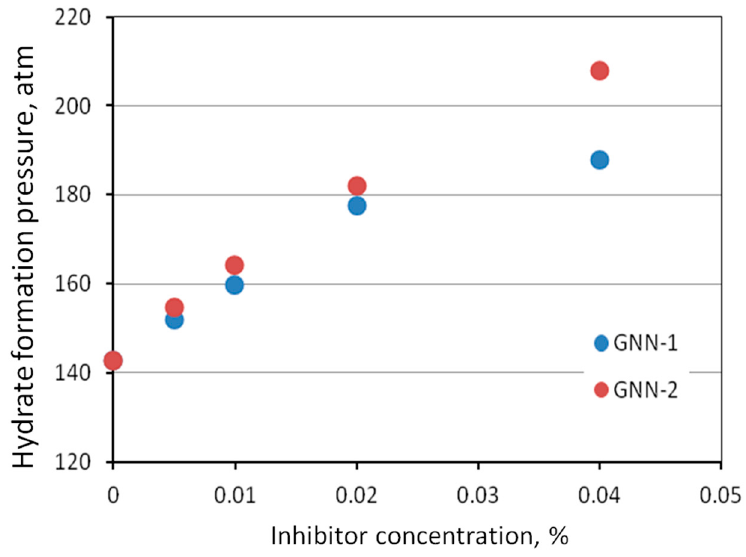
Figure 15. The pressure at the beginning of gas hydrate formation of petroleum gas on the concentration of laboratory formulations of inhibitors.